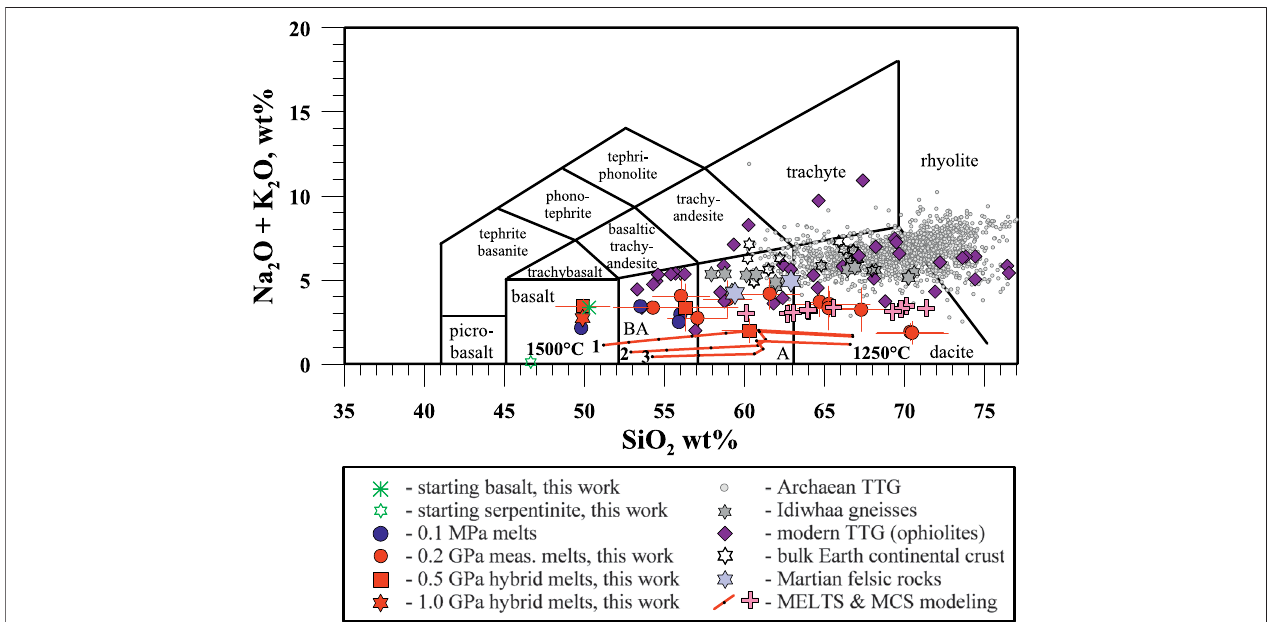
FIGURE 5 | Sum of alkali oxides (in wt%) vs. SiO 2 (in wt%) in interstitial glasses produced during hybrid and mixed runs of serpentinite-basalt interaction plotted in the classi fi cation diagram of Le Maitre (2002). The major element compositions of the measured ( “ meas. melts ” , red dots are recalculated to 100% on a volatile-free basis).Theerrorbarsre fl ectthefelsicglassheterogeneitycomparedtothemeanvalues.Theglasscompositionsarecomparedwiththestartingbasaltandserpentinites, theanhydrous0.1 MPaexperimentalglasses(Fisk,1986),modernTTGorplagiogranitesinmantlesectionofophiolites(Amrietal.,1996,2007;Shervais,2008;Xu et al., 2017), the bulk Earth continental crust (Wedepohl, 1995; Rudnick and Gao, 2003), Archaean TTG (Moyen and Martin, 2012), Acasta Gneiss Complex rocks (Idiwhaa gneisses) (Reimink et al., 2016), Martian felsic rocks (Sautter et al., 2016). BA, basaltic andesite; A, andesite. Red lines with black points correspond to the thermodynamic modeling using MELTS of equilibrium liquids coexisting with mixture of 80 – 95 wt% serpentinite with 20 – 5 wt% basalt ( R < 1) at 0.2 GPa and different temperatures ranging from 1,500 ° C to 1,250 ° C and redox conditions of Δ QFM+2: 1) 80 wt% serpentinite and 20 wt% basalt ( R (cid:1) 0.25); 2) 90 wt% serpentinite and 10 wt% basalt ( R (cid:1) 0.11), and 3) 95 wt% serpentinite and 5 wt% basalt ( R (cid:1) 0.05) ( Supplementary Table S6 ). The compositions modeled at 1,250 ° C are corrected according to